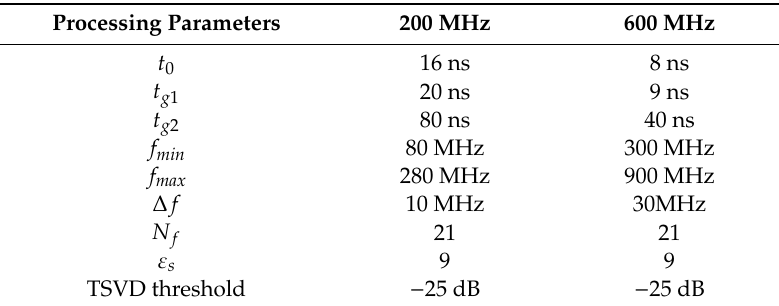
Table 1. Processing parameters. Processing Parameters